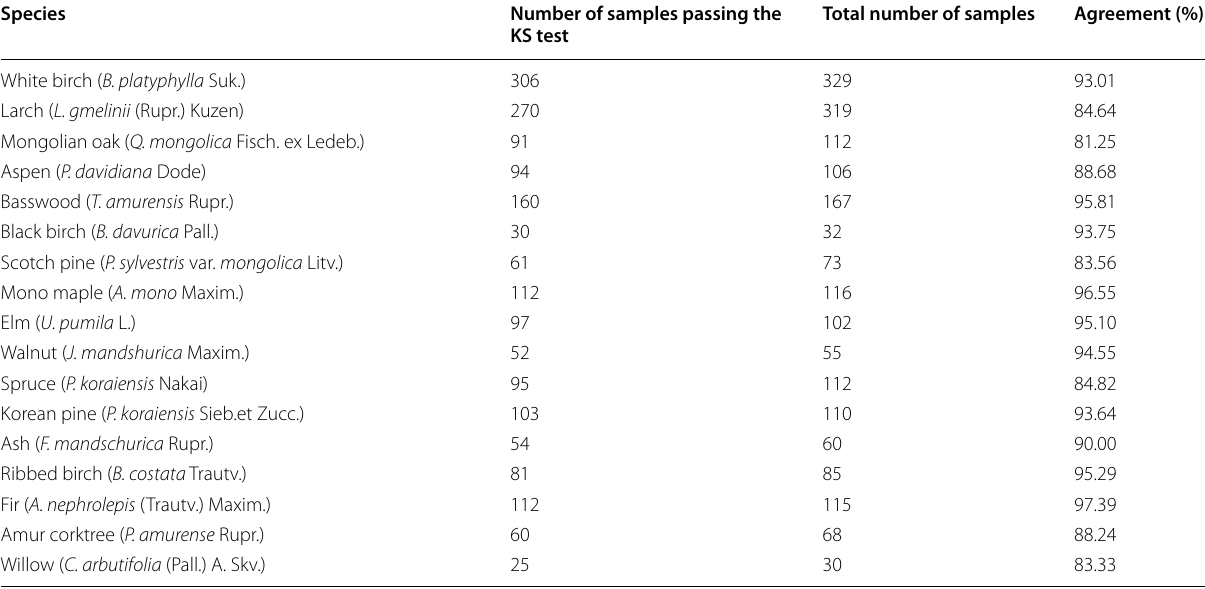
Agreement was defined as the percentage of samples that passed the KS test ( P > 0.05)